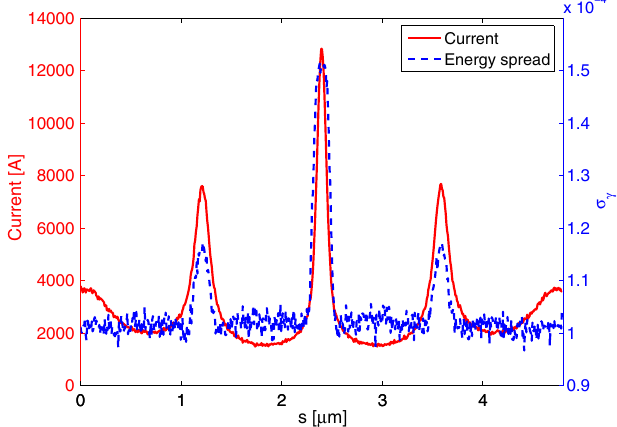
FIG. 7. Current profile (red solid line) and slice energy spread (blue dashed line) at the entrance of the